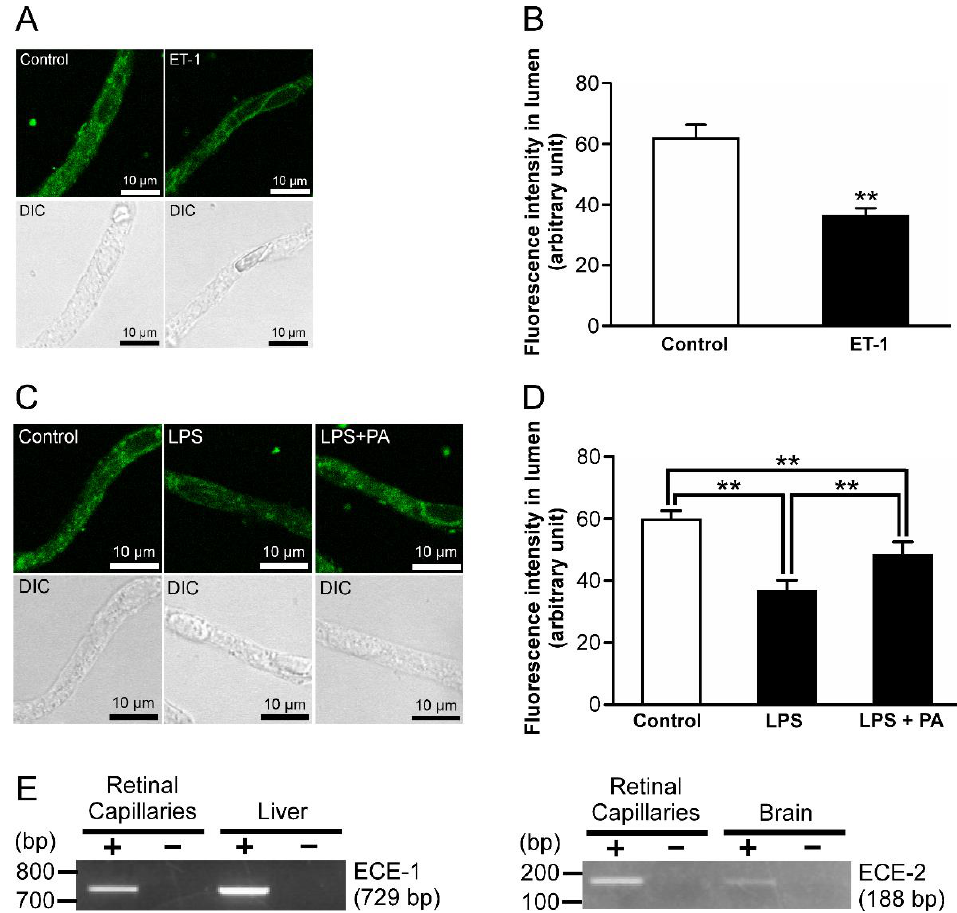
Figure 5. P-gp attenuation by endothelin-1 (ET-1) in the retinal capillaries under LPS-treated condi- tions. ( A , C ) Representative confocal images of isolated rat retinal capillaries after incubation with NBD-CSA at 4 µ M for 60 min. ( A ) The capillaries were preincubated with ECF buffer in the absence (control) or presence of 1 nM ET-1 for 30 min. ( C ) The capillaries were preincubated with 1 ng/mL LPS in the absence or presence of PA (ECE inhibitor) at 3 µ M. ( B , D ) Quantification of NBD-CSA fluorescence in the lumens of retinal capillaries. ( E ) mRNA expression of ECE-1 or ECE-2 in rat retinal capillaries. RT-PCR analysis was performed in the presence (+) or absence ( − ) of reverse transcriptase using specific primers for ECE-1 or ECE-2. The rat liver or brain was used as the positive control. Each column represents the mean value for 10 capillaries from a single preparation; variability is given by S.D. bars. Units are expressed as arbitrary fluorescence (scale 0–255). ** p < 0.01, significantly different between the groups. Capillary images were captured using a